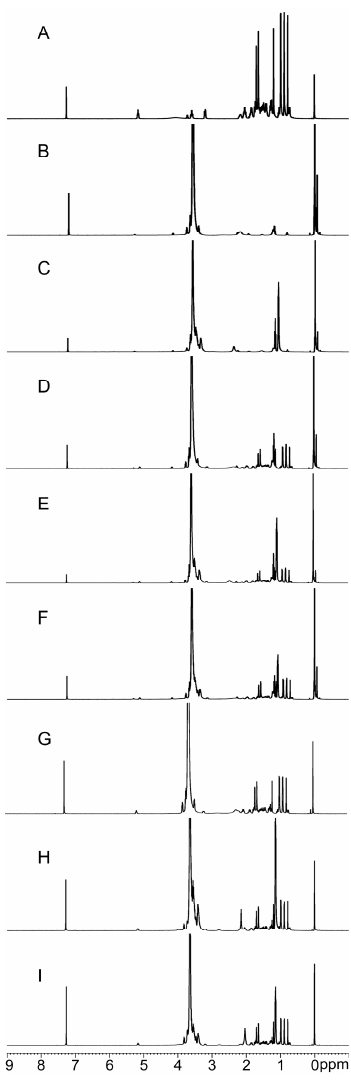
Figure 5. Nuclear magnetic resonance (NMR) spectra of PPD ( A ), PEG6000 ( B ), F68 ( C ), F1 ( D ), F2 ( E ), F3 ( F ), PEG6000 PM ( G ), F68 PM ( H ), PEG6000 and F68 PM ( I ). 1 H-NMR spectra were used to describe the interactions between PPD and PEG, F68, or in both